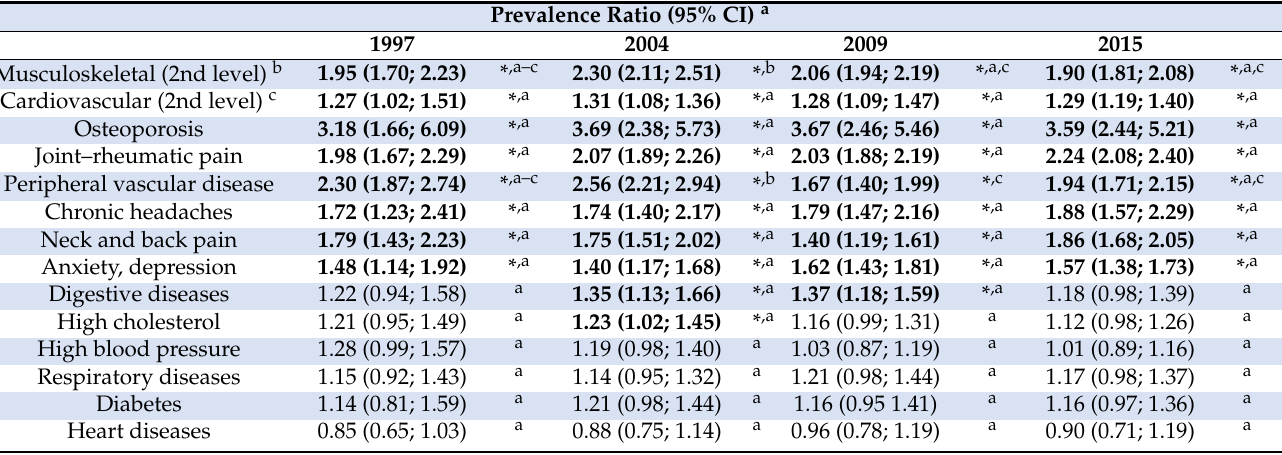
Table 2. Differences between men and women in selected chronic morbidities. Canary Health